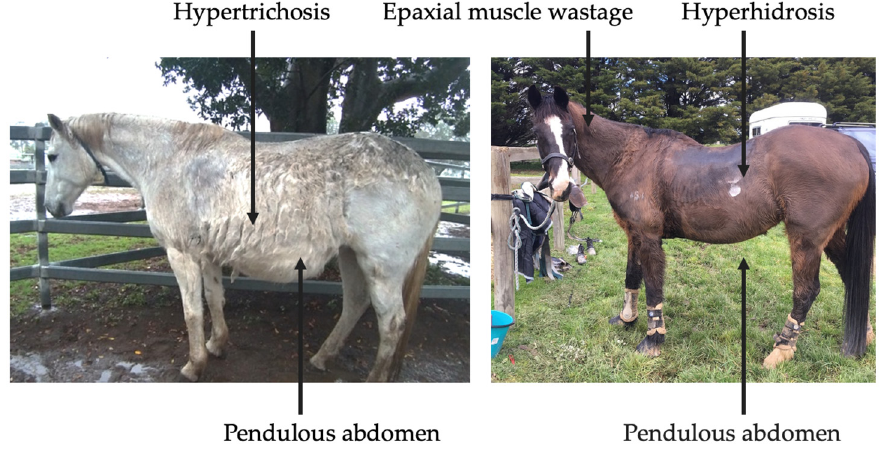
Figure 3. Clinical signs associated with severe, end-stage PPID.